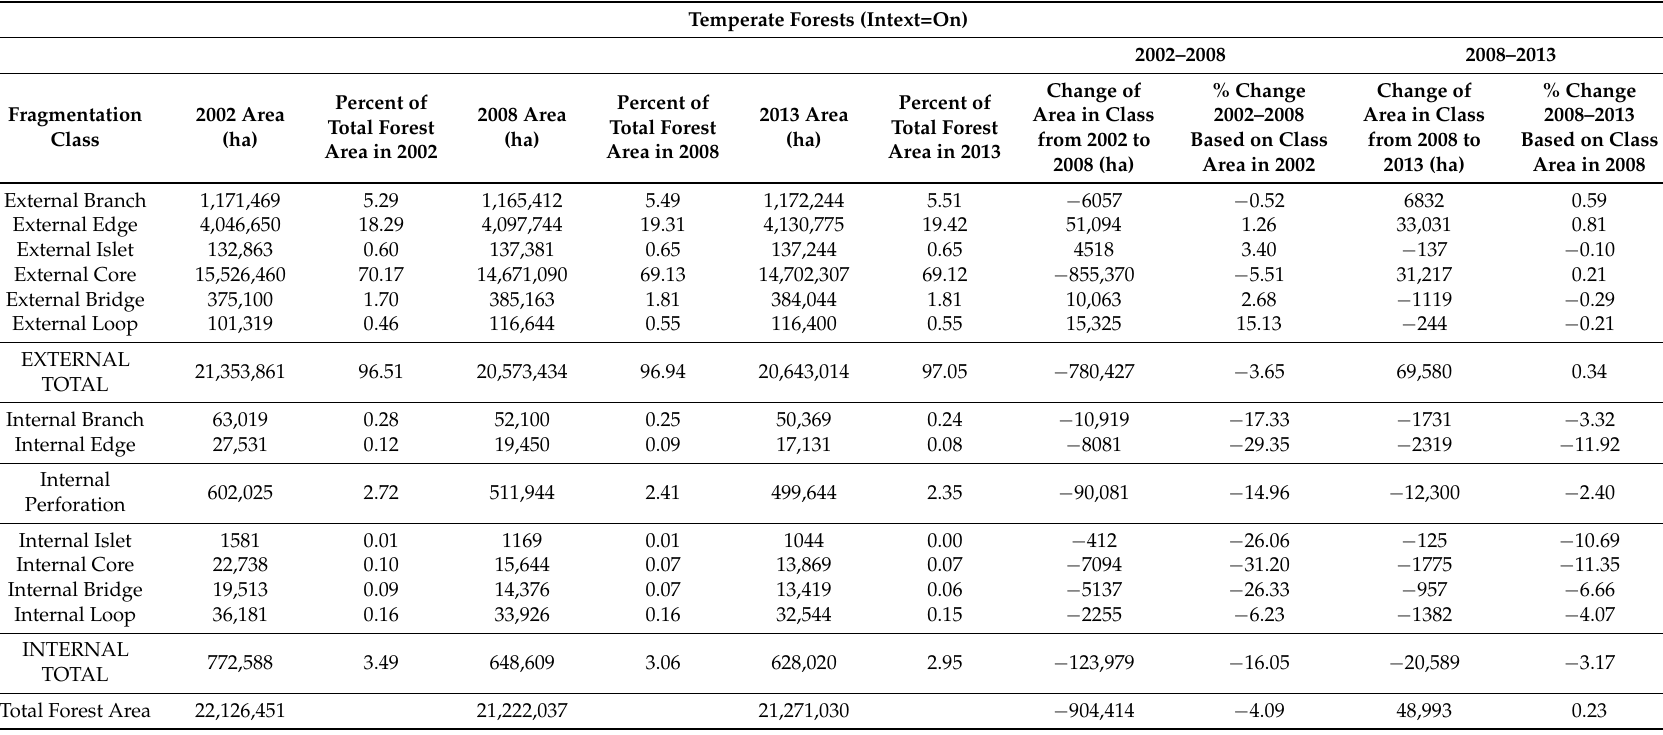
Table 5. Areas in each fragmentation class (intext = “On”) for the temperate forests in 2002, 2008 and 2013. The differences in area and percent changes between dates are presented in the last columns on the right-hand